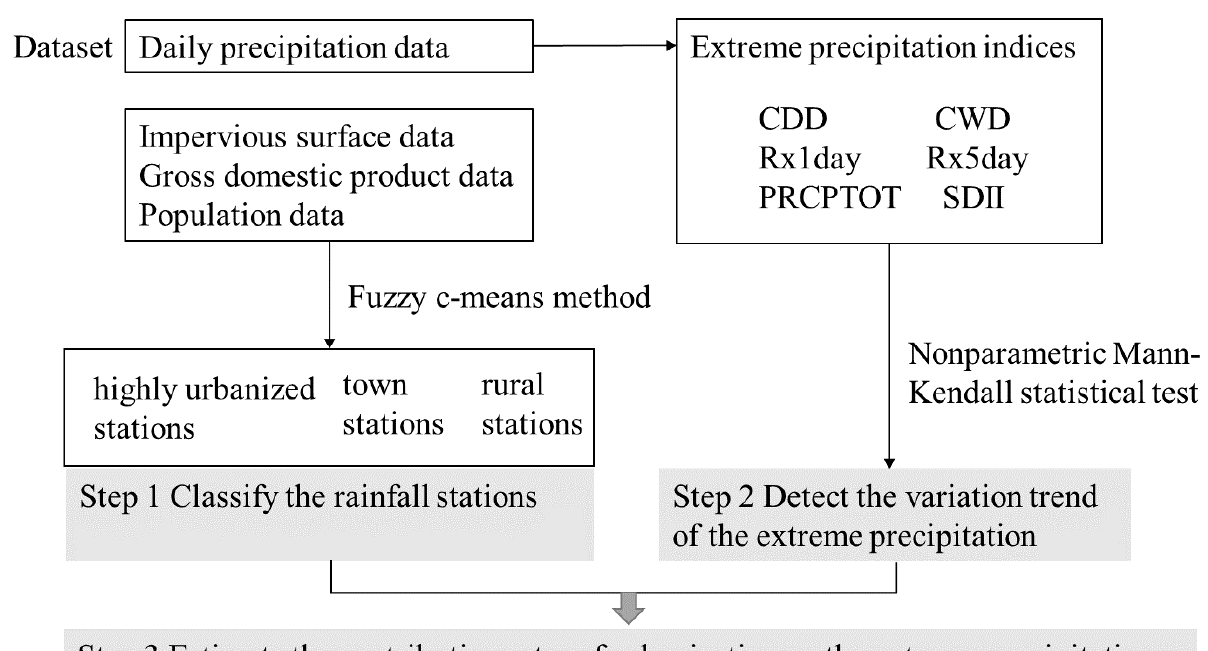
Figure 2. The flowchart of our methods.